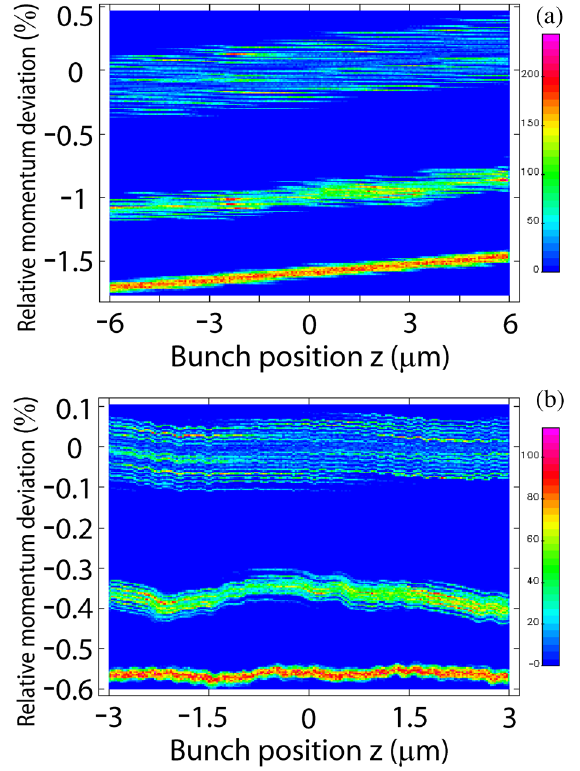
FIG. 12. (Color) Central portion of the longitudinal phase space without a laser heater (upper), in the presence of a laser (cid:3) 1 : 5 mm (middle) and with (cid:27) heater with (cid:27) r (lower). Curves offset vertically for clarity. Simulations are seeded with 1% initial density modulation at (cid:5) (a) End of BC2 at 4.5 GeV. (b) Undulator entrance at 14 GeV.